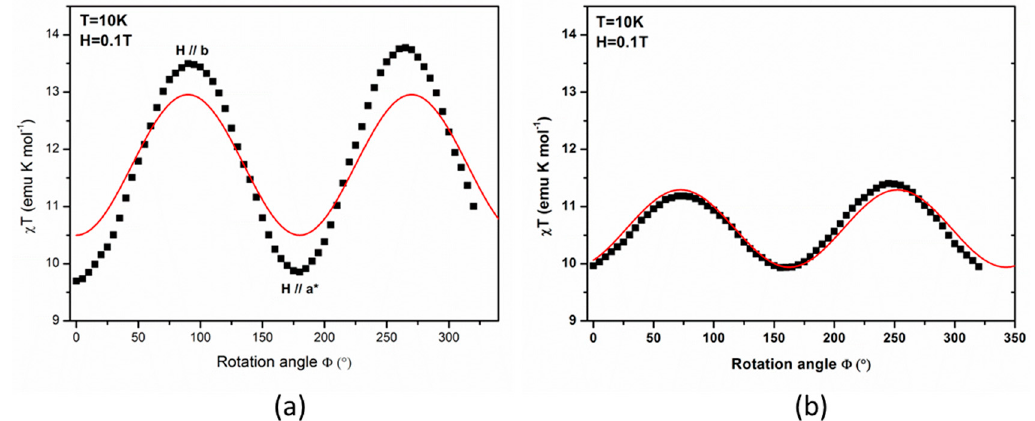
Figure 4. Dependence of the product of the magnetic susceptibility with temperature ( χ T ) with the rotation angle Φ at 10 K, under a static field of 0.1 T: a ) for a rotation around the crystal (cid:1855)(cid:1318) axis and b ) for a rotation around the crystal (cid:1854)(cid:4652)(cid:1318) axis . The red curve is the simulation from the PND data.